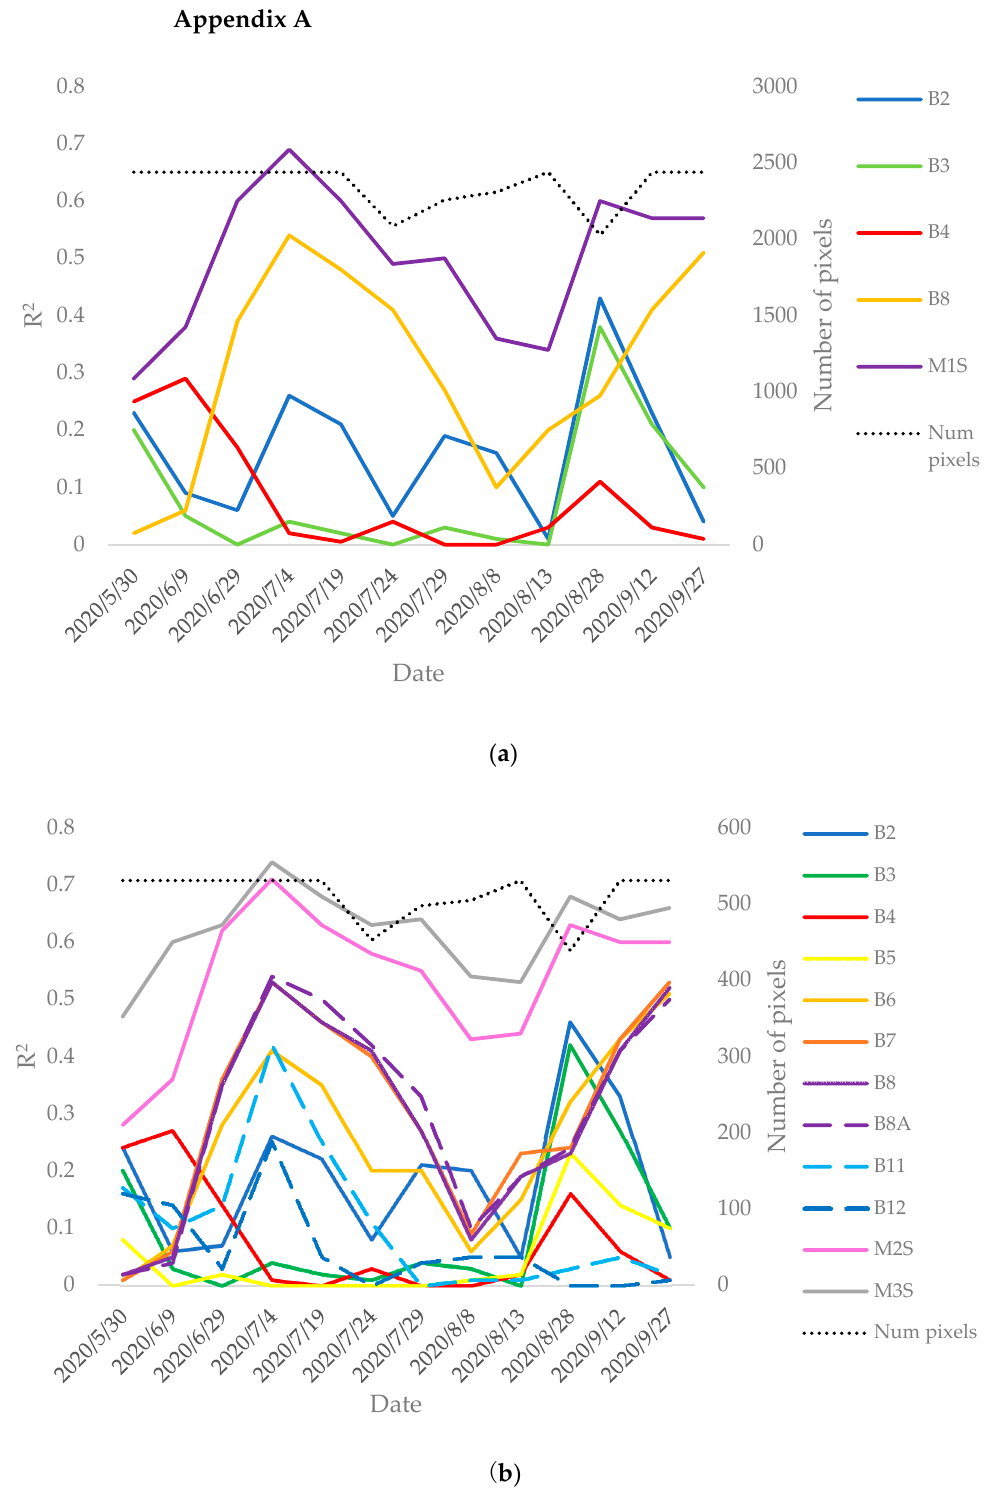
Figure A1. Coefficient of determination timeseries evolution focusing on JSendra training data of each band at 10 m ( a ) and at 20 m ( b ) spatial resolution and the linear combination of all of them against the final yield at pixel level (M1S, M2S and M3S). Additionally, the number of pixels is added as a reference of the cloud situation.